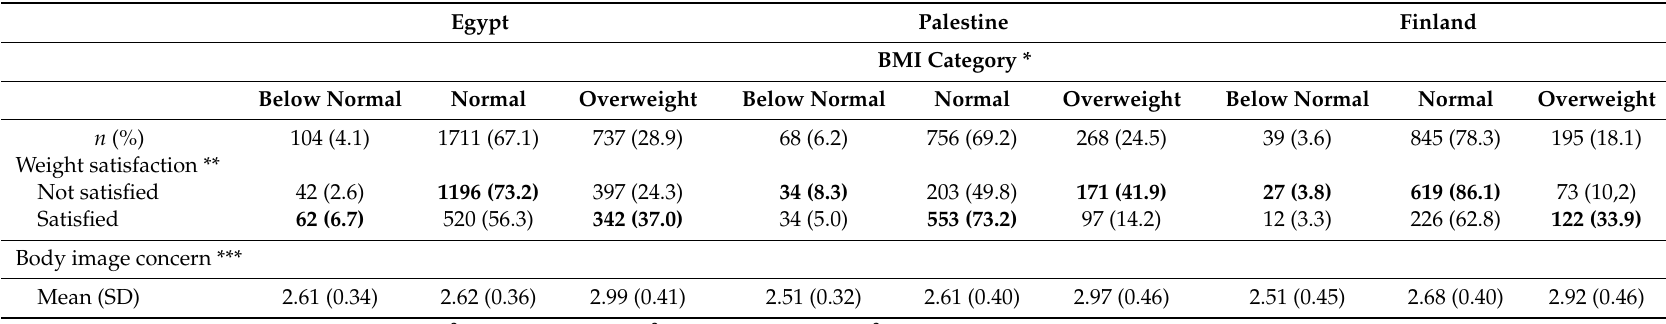
Table 2. Weight satisfaction and body image concern by BMI category among university students in Egypt, Palestine, and Finland. Egypt